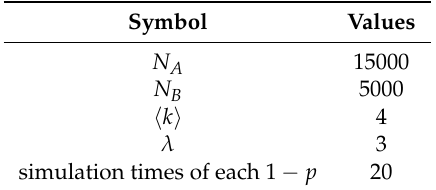
Figure 6. The fraction of function nodes in systems when f N = 50% in ER–ER, ER–SF, SF–ER, and SF–SF systems, which are shown in ( a – d ), respectively. Table 3. The parameters of our simulation